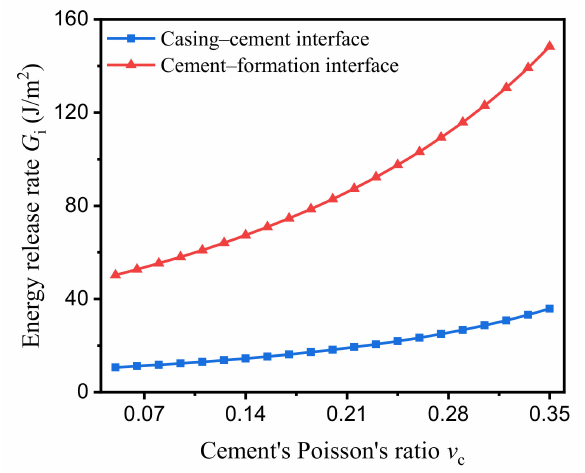
Figure 5. E ff ect of cement’s Poisson’s ratio on interfacial